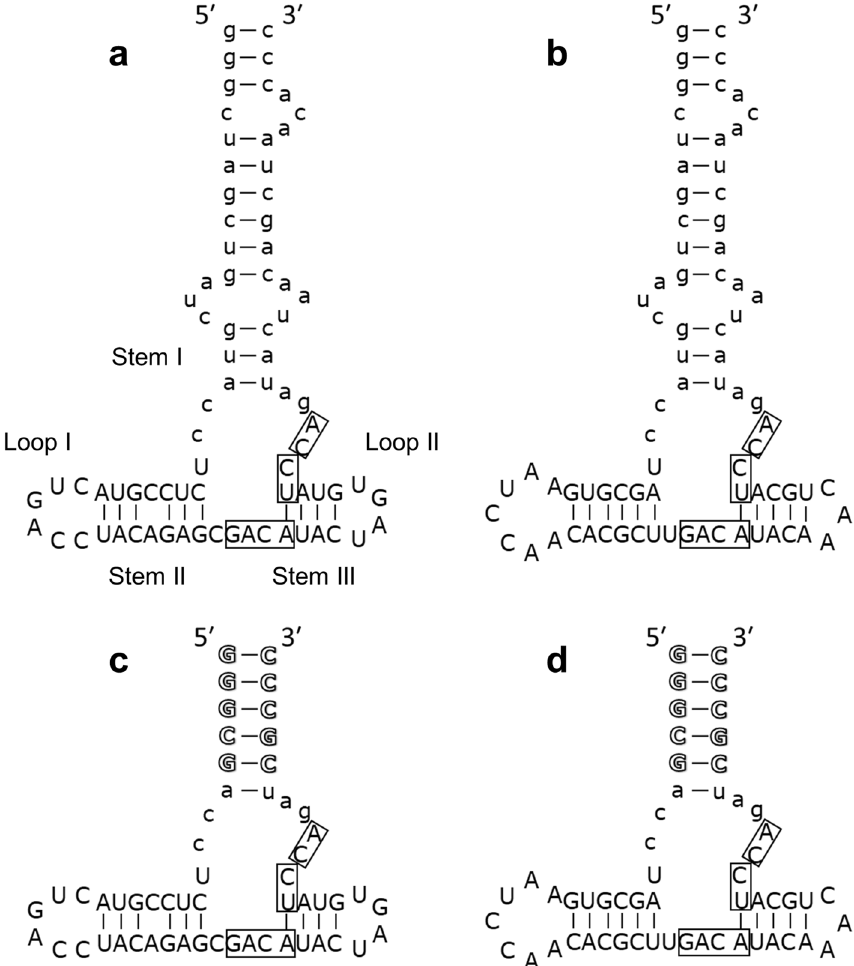
Figure 5. Predicted secondary structures of aptamers, F5f1 ( a ), F5f3 ( b ), F5f1_56 ( c ), and F5f3_56 ( d ). The consensus sequences are boxed. The lowercase and outline letters indicate the primer binding sequence and the added sequence,